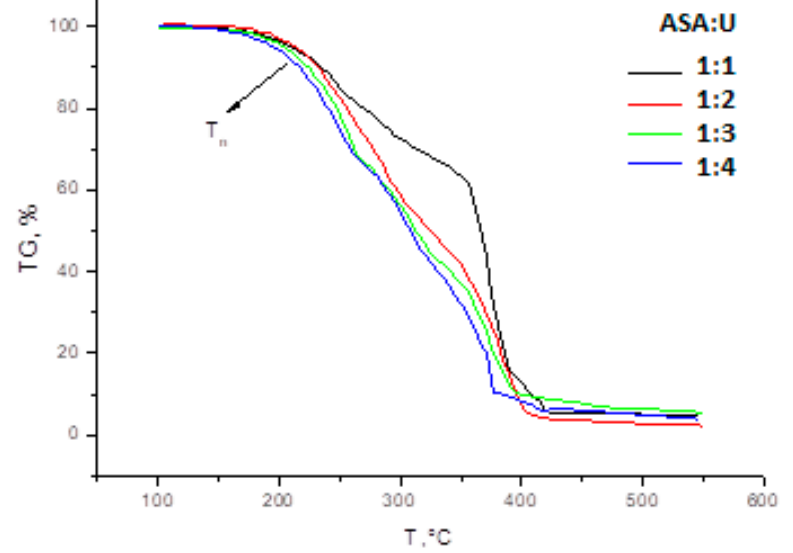
Figure 4. Results of thermogravimetric analysis (TG) of a mixture of ammonium sulfamate with urea.